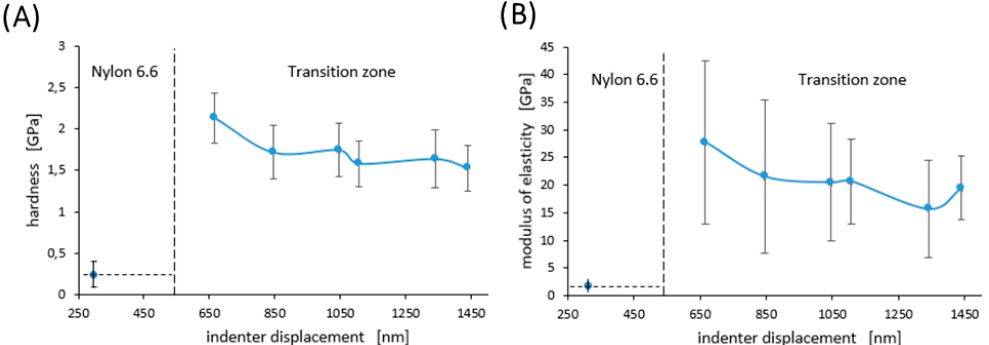
Figure 9. Hardness—( A ), and modulus of elasticity—( B ) for a nylon coating with a thickness of 500 nm and for a transition zone. Error bars represent ± standard deviation.